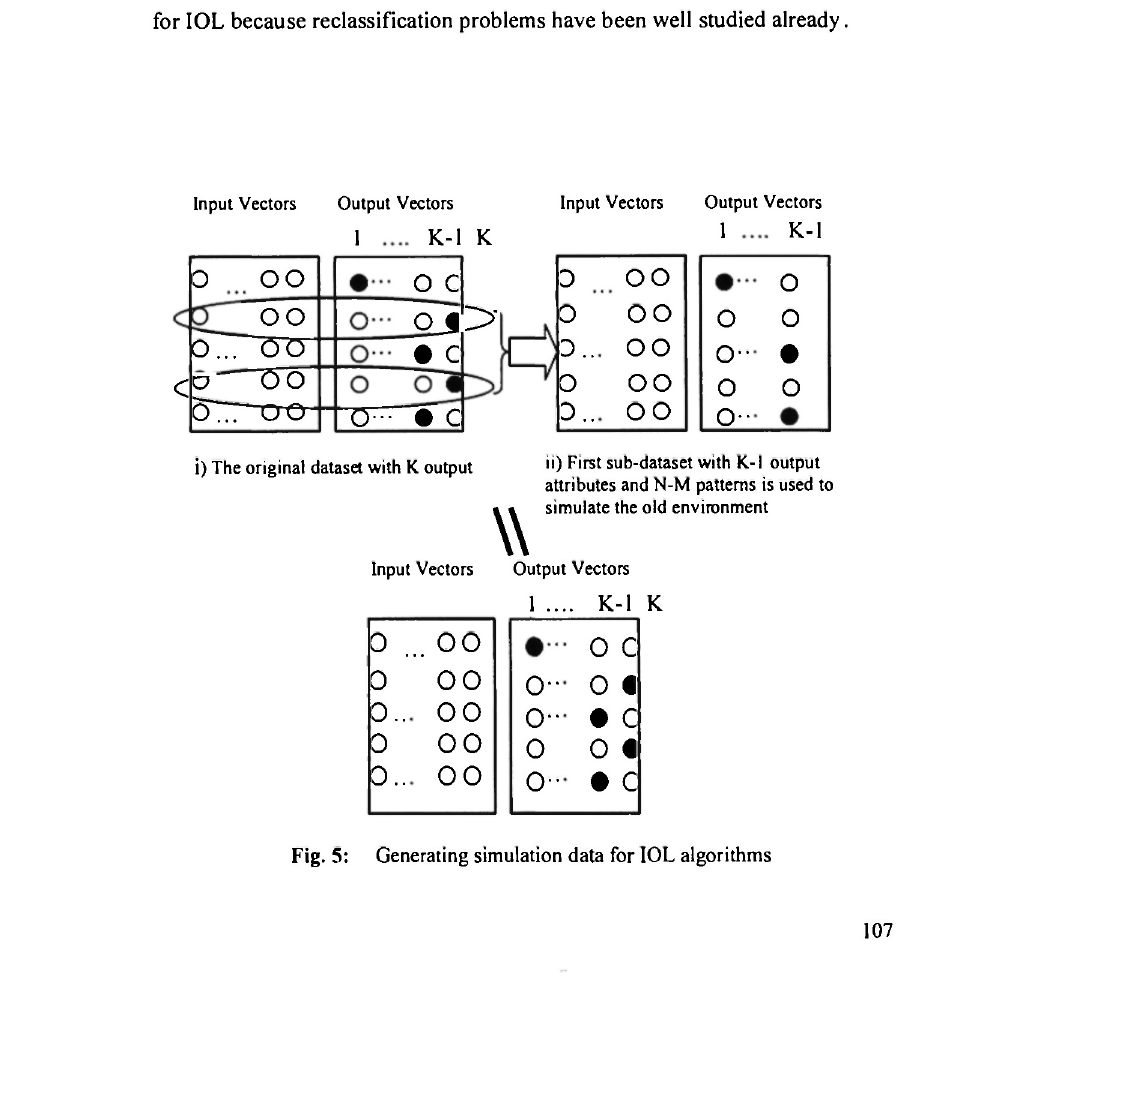
Fig. 5: Generating simulation data for IOL